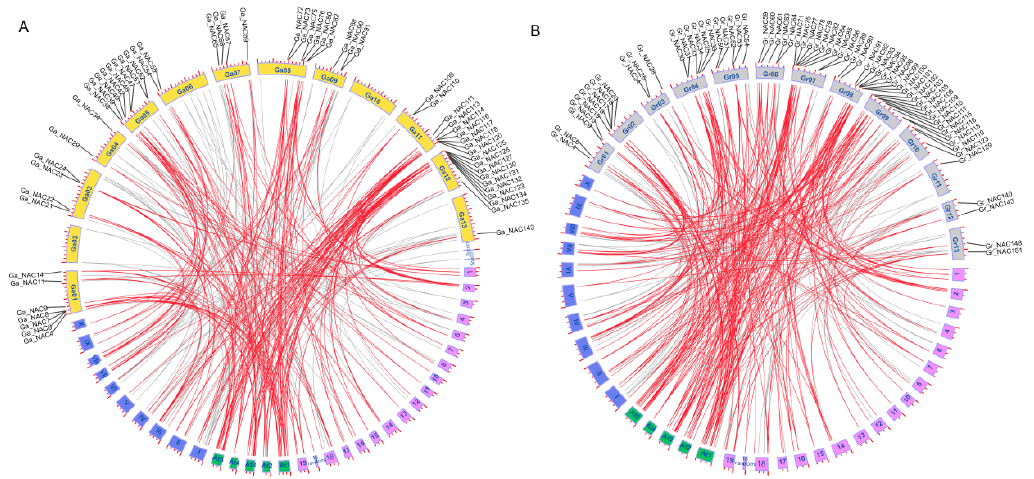
Figure 3. Synteny analysis of NACs between diploid cotton and Arabidopsis, cacao and grape. Blue, green, purple, yellow ( A ) and grey ( B ) blocks indicate the chromosomes of cacao, Arabidopsis, grape, G. arboreum ( A ) and G. raimondii ( B ), respectively. The gene labels and red lines indicate collinear relationship of genes with high conservation.